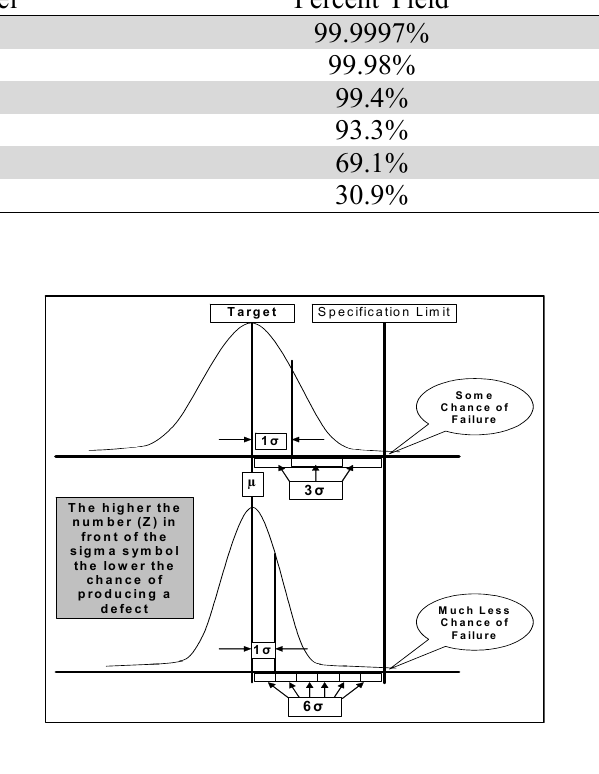
Fig. 1. Reducing Variation - Reducing